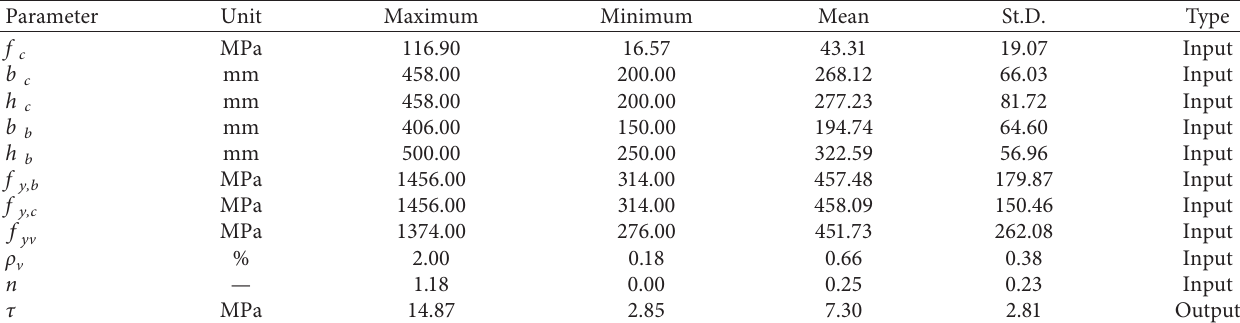
Table 2: Statistics of parameters for the internal RC beam-column